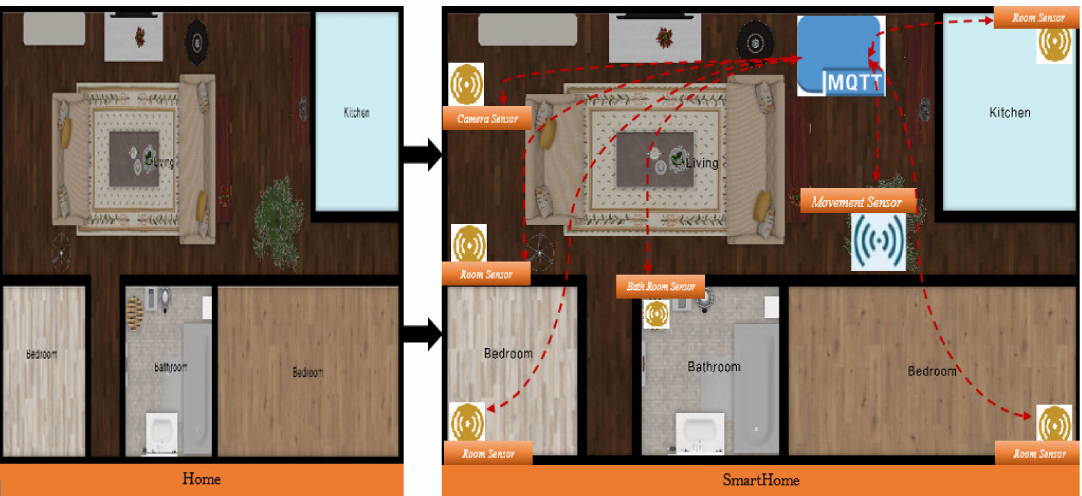
Figure 2. The conceptual smart home MQTT